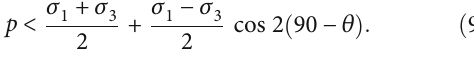
are impermeable and constrained by the con fi ning pressure.